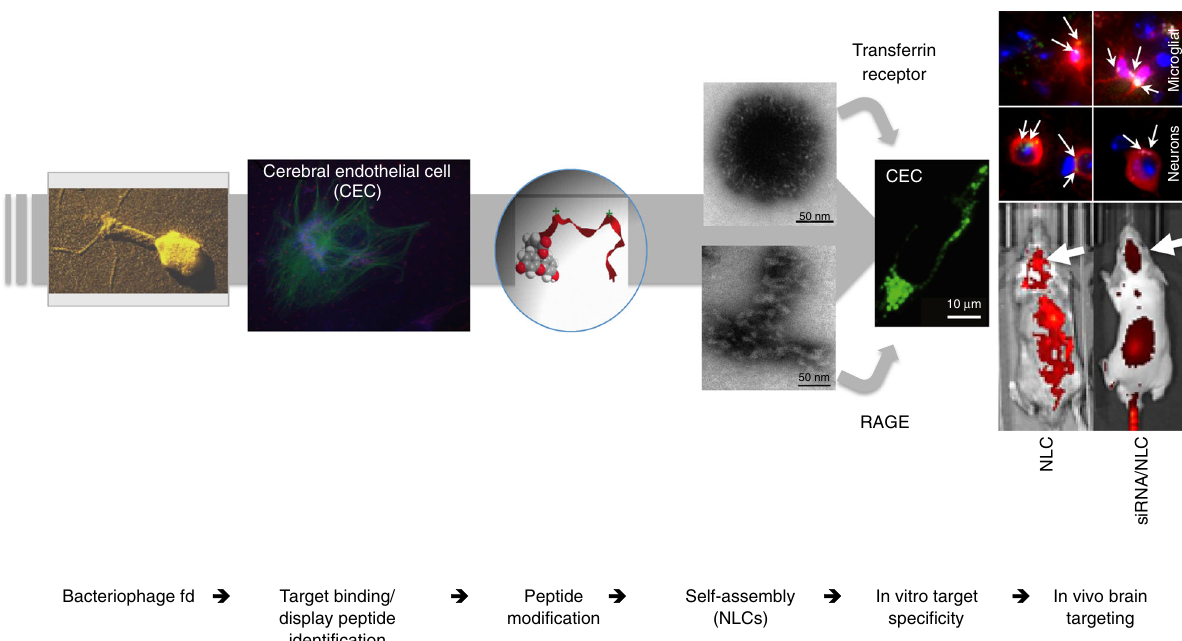
Fig. 7 Schematic summary of NLC construction and active targeting of the brain. Animal images represent FAM-CGY NLC (left; corresponding to core-shell nanoparticle morphology) and Cy5-siRNA/FAM-CGY NLC (right; corresponding to nano fi bre morphology) deposition in the brain at 2 h post intravenous injection and corresponding immuno fl uorescent brain sections at 4 h, showing NLC deposition in neurons and microglial